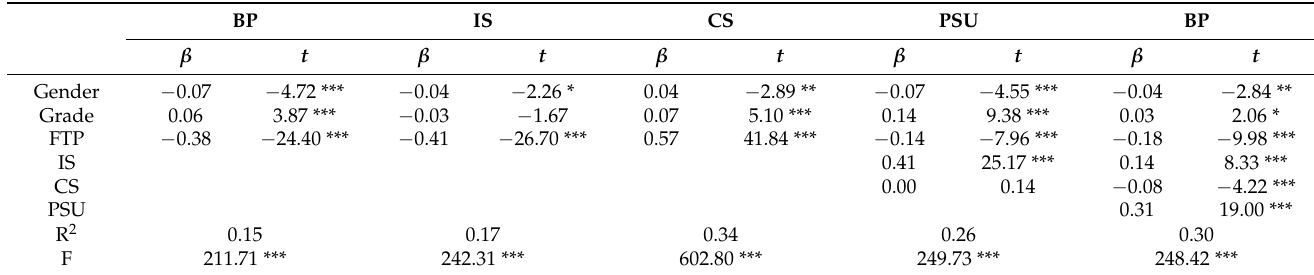
Table 3. Hierarchical multiple regression results of the effects of future time perspective on bedtime procrastination through dual-mode self-control and problematic smartphone use.